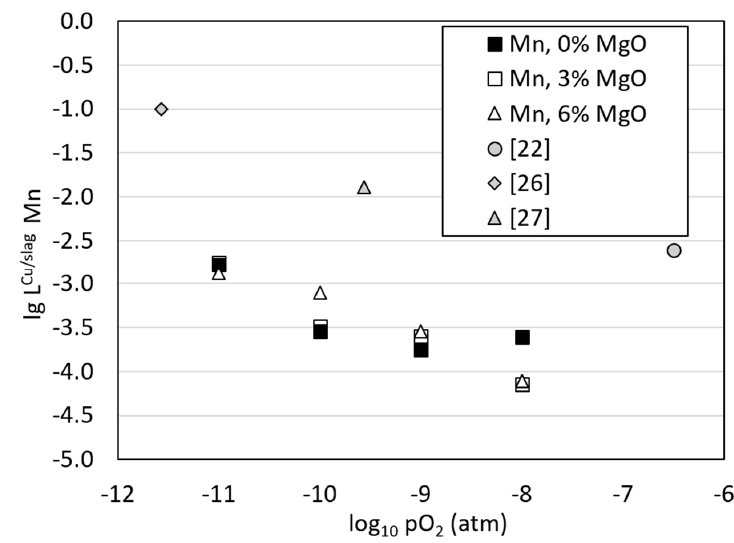
Figure 7. The distribution coefficient of manganese between copper alloy and slag as a function of oxygen partial pressure. Results from three earlier studies [22,26,27] have been plotted for comparison.